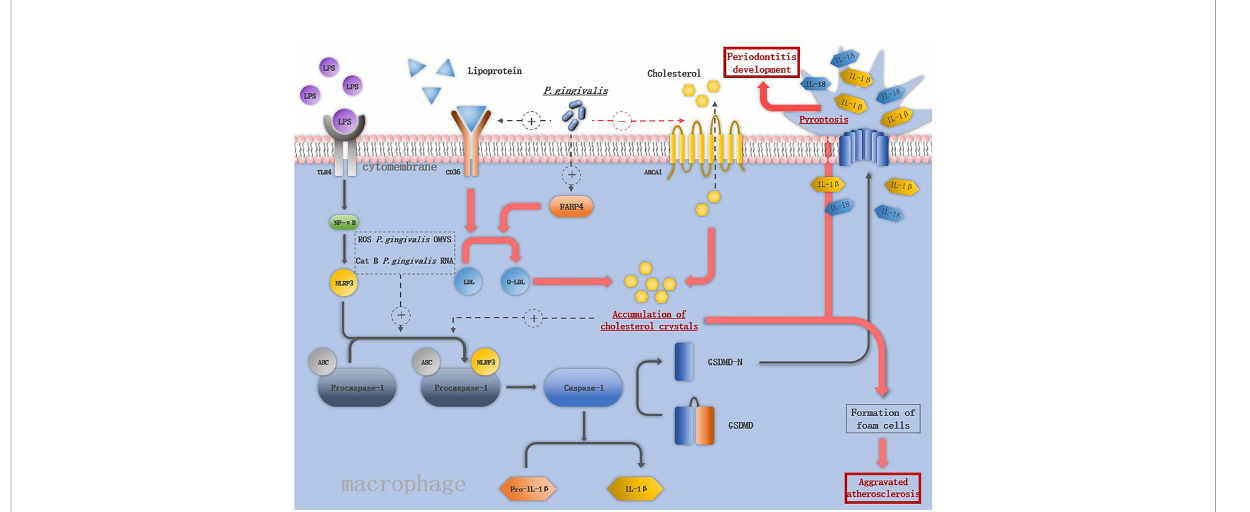
FIGURE 2 The mechanism of P. gingivalis in activating the in fl ammasomes in macrophage: LPS binds to TLR4 and activates NF-macrophage:increases the expression of keys are assembled in response to the second stimuli such as ROS, CatB, P. gingivalis OMVS and P. gingivalis RNA. The activation of NLRP3 in fl ammasome induces the maturation of IL-1ression of keys are assembled in response to the second stimuli such as ROS, Cs macrophage pyroptosis. Pore formation in the cell membrane leads to the release of IL-1 b and IL-18 and promotes the destruction of periodontal tissue. P. gingivalis increases the expression of CD36 and FABP4, promoting the internalization of o-LDL and intracellular conversion of o-LDL to cholesterol crystals, which is able to activate NLRP3 in fl ammasomes. P. gingivalis also downregulates the ABCA1 on macrophages to promote cholesterol accumulation. The accumulation of cholesterol together with the releases of cellular components by pyroptosis contribute to the formation of foam cells, the hallmark cells of